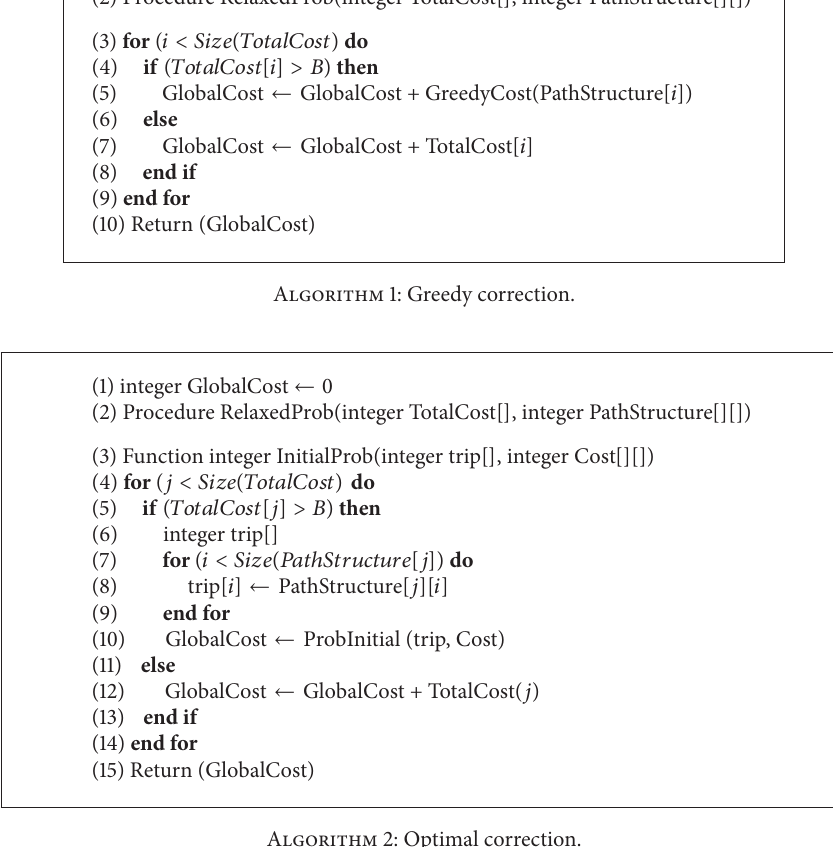
Algorithm 2: Optimal